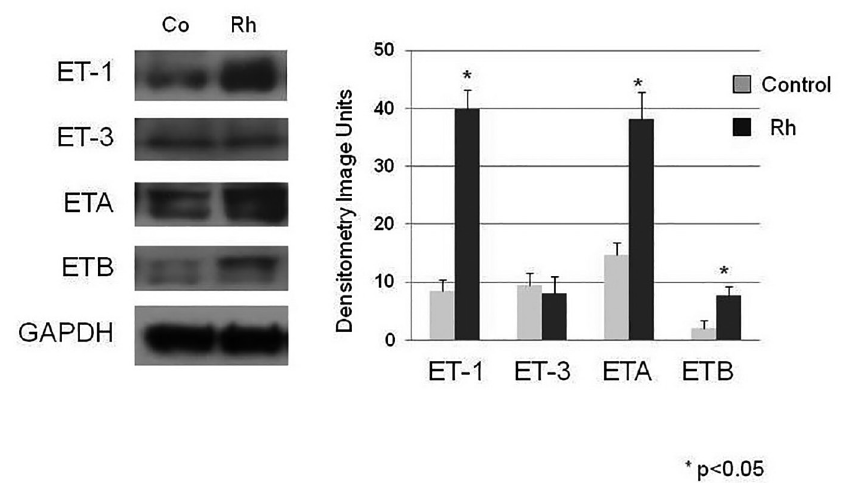
Fig. 4 - Western blot analysis of RF versus control mitral valve tissue extracts. Left. Representative blots for ET-1, ET-3, ETA and ETB receptors from control (Co) and rheumatic (Rh) mitral valve extracts. Right. Histograms of mean ± SD of pooled data from control and rheumatic